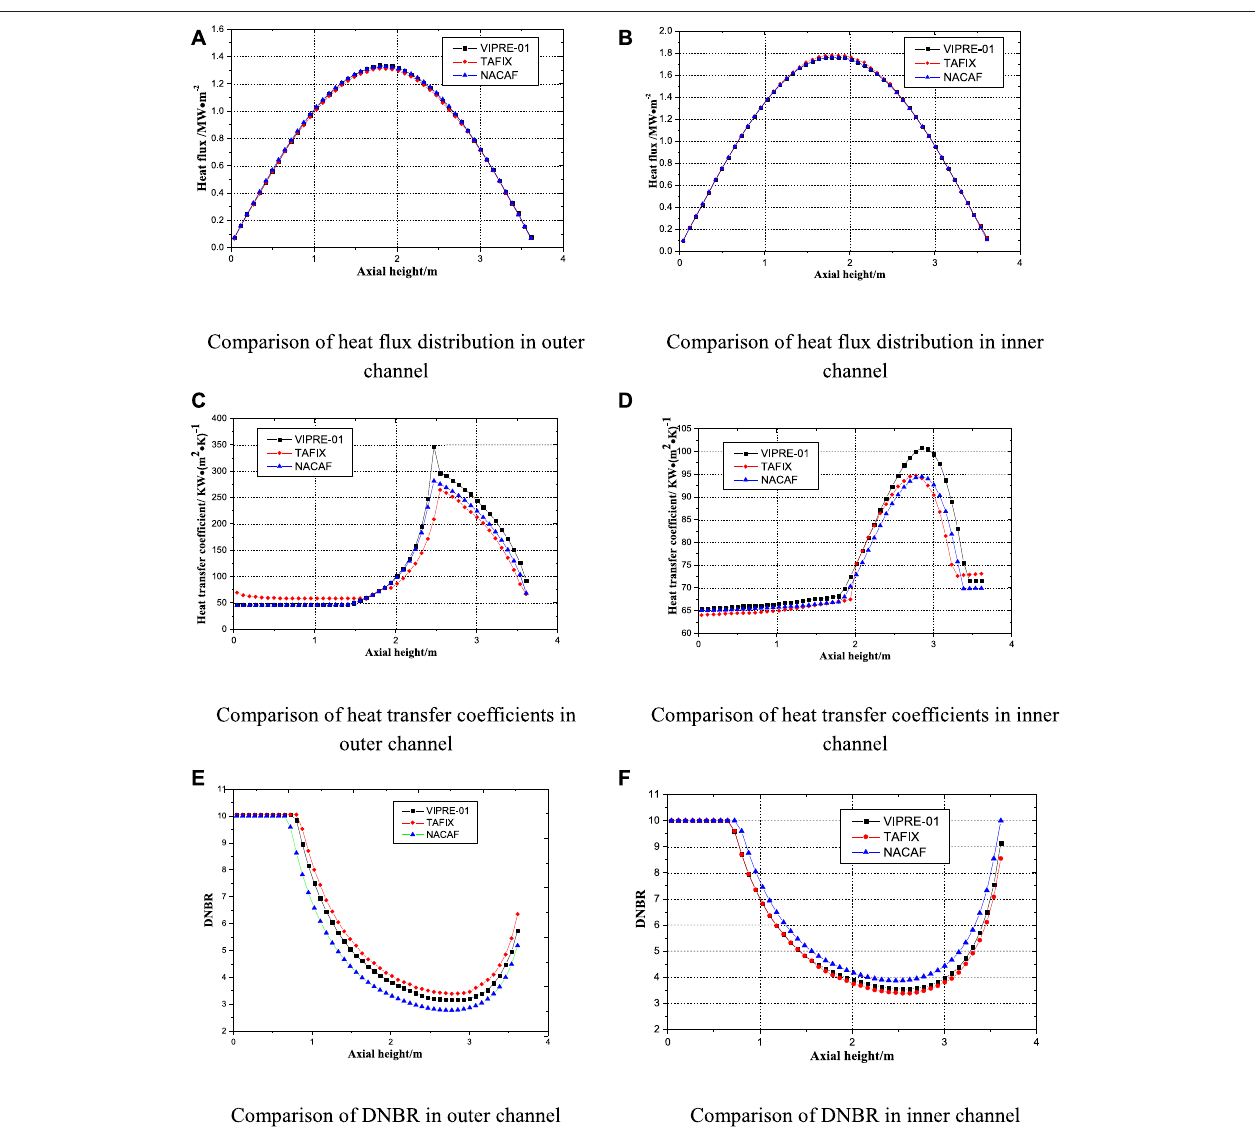
FIGURE 6 | Comparison of thermal hydraulic parameters calculated by three sub-channel codes.